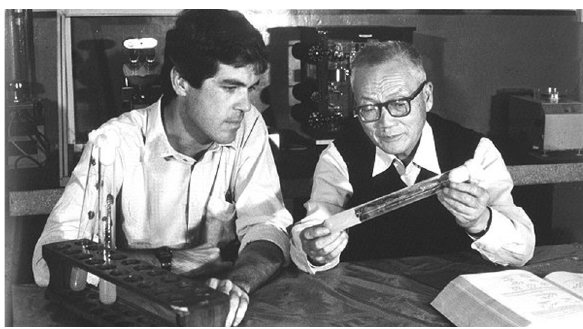
Figure 2. Prof. Chen Hua-Gui and his American